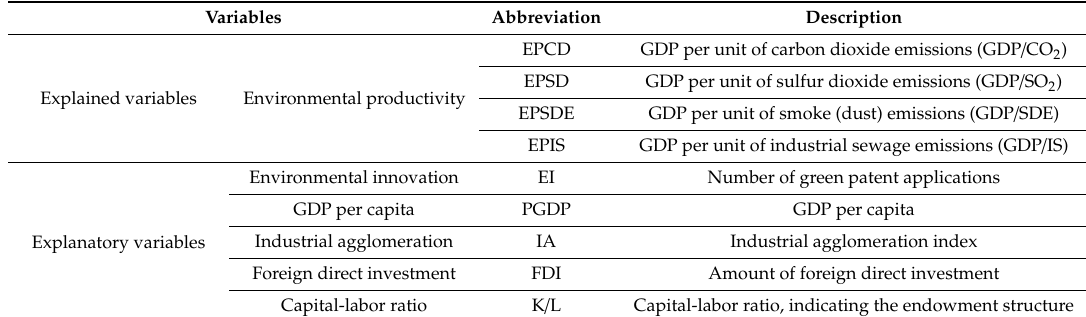
Figure 1. Flow chart of research framework. Table 1. Calibrated variables. GDP, gross domestic